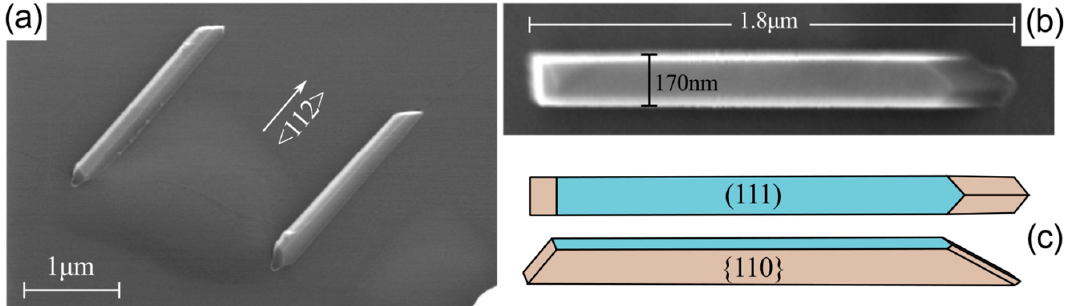
Figure 2. SEM image of GaAs fins oriented along a < 112 > direction. ( a ) tilted view of two adjacent fins; ( b ) top view and ( c ) schematics of the nanomembrane morphology showing the lateral {110} and top (111) faceting.